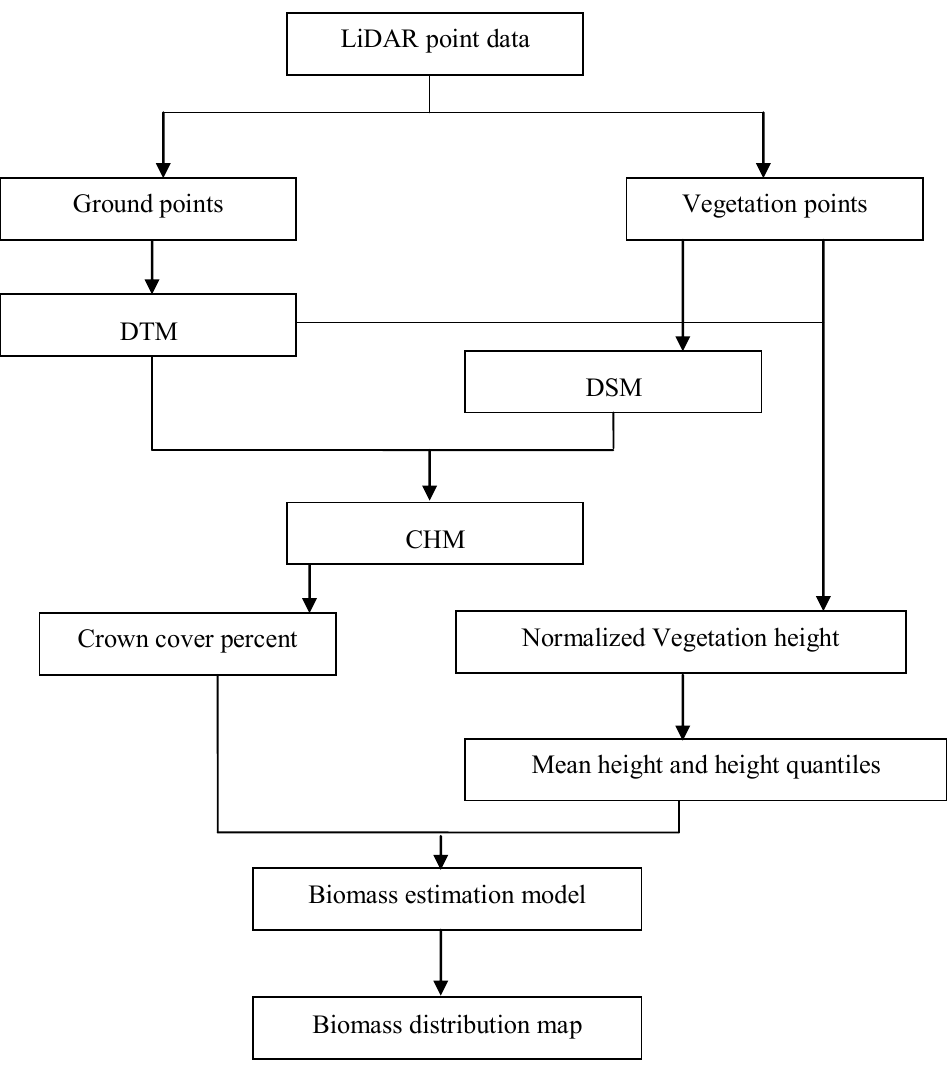
Figure 2. The main LiDAR processing steps in this study are illustrated in a flow